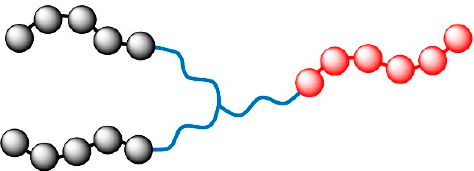
Table 1. Input parameters ( E ij ) information.